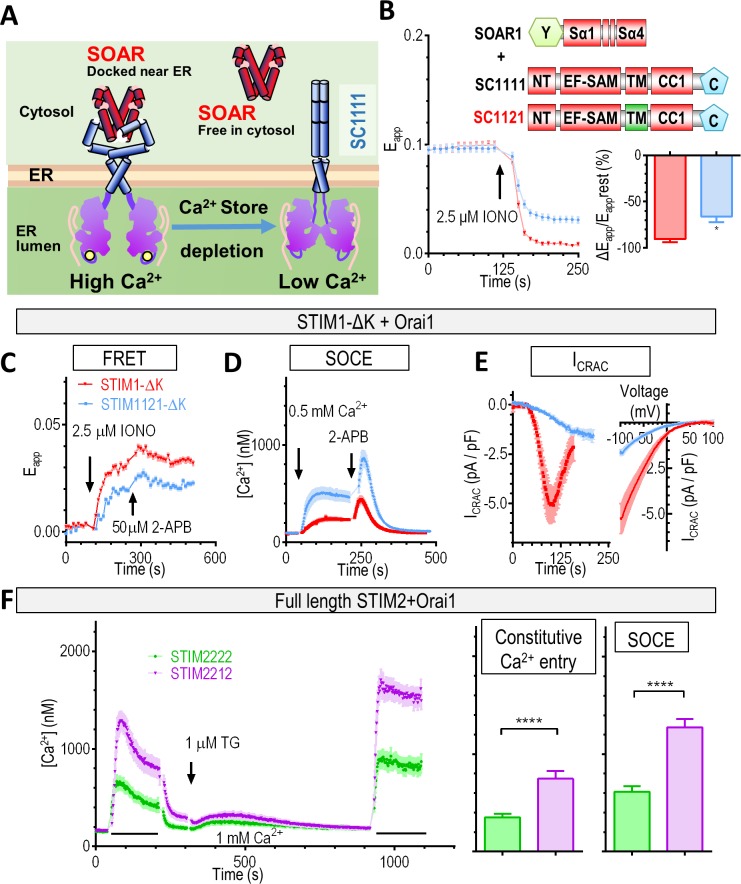
The STIM2-TM domain activates the cytosolic region of STIMs less efficiently than that of STIM1.(A) A diagram of colocalization of the ER-localized SC1111 and SOAR under resting or Ca2+ store-depleted condition. (B) When the STIM1-TM is replaced with that of STIM2, IONO-mediated Ca2+ store depletion induced slower and smaller decrease in the FRET signals between SC1211 and SOAR than SC1111 and SOAR. Left: typical traces; right: statistics of the rate of FRET decrease (n = 4, *P < 0.02, t test; –90.47% ± 6.66% versus –66.13% ± 11.93%). (C–E) HEK293-Orai1-CFP stable cells transiently expressing STIM1111-ΔK (STIM1-ΔK)-YFP or STIM1121-ΔK-YFP. (C) Typical FRET signals of STIM1121-ΔK and Orai1 before and after Ca2+ store depletion. IONO induced a smaller FRET increase in STIM1121-ΔK–expressing cells than in STIM1-ΔK–expressing cells (0.028 ± 0.001 versus 0.018 ± 0.001, n = 4, ****P < 0.0001, t test). (D) Typical SOCE responses as indicated by Fura-2 imaging. TG-induced SOCE responses were reduced in cells expressing STIM1121-ΔK (358.7 ± 49.35 versus 117.7 ± 12.94, n = 4, ****P < 0.0001, t test). Cells were pretreated with 1 μM TG for 10 min to deplete the ER Ca2+ stores before the measurements. TG was also present during the recordings. (E) Average whole-cell ICRAC recordings. Left: average time course of whole-cell ICRAC currents measured at –100 mV. Currents mediated by STIM1121-ΔK developed significantly more slowly than control (time to peak, 72 ± 7 s versus 147 ± 9 s, n = 7, ****P < 0.0001, t test), with the maximal current density also reduced (–5.5 ± 0.8 pA/pF versus –1.5 ± 0.1 pA/pF, n = 7, *****P < 0.0004, t test). To aid comparison, the individual traces were aligned according to the onset of ICRAC (+36 s). Right: average I–V relationships at the peak of ICRAC. (F) Ca2+ responses of HEK293-Orai1-CFP stable cells transiently expressing STIM2222-ΔK (STIM2-ΔK)-YFP or STIM2212-ΔK-YFP. Left: representative traces. Middle: statistics for constitutive Ca2+ entry, Right: statistics for SOCE (n = 3, ****P < 0.0001, t test). Individual numerical values underlying (B–F) may be found in S1 Data. 2-APB, 2-Aminoethoxydiphenyl borate; CC1, coiled-coil 1; CRAC, Ca2+-release–activated Ca2+ current; ER, endoplasmic reticulum; FRET, Förster resonance energy transfer; HEK293, human embryonic kidney 293 cells; IONO, ionomycin; I–V, current–voltage; NT, N terminus; SAM, sterile alpha motif; SC, STIM1-CC1 construct; SOAR, STIM-Orai–activating region; SOCE, store-operated Ca2+ entry; STIM, stromal interaction molecule; TG, thapsigargin; TM, transmembrane region; YFP, yellow fluorescent protein.